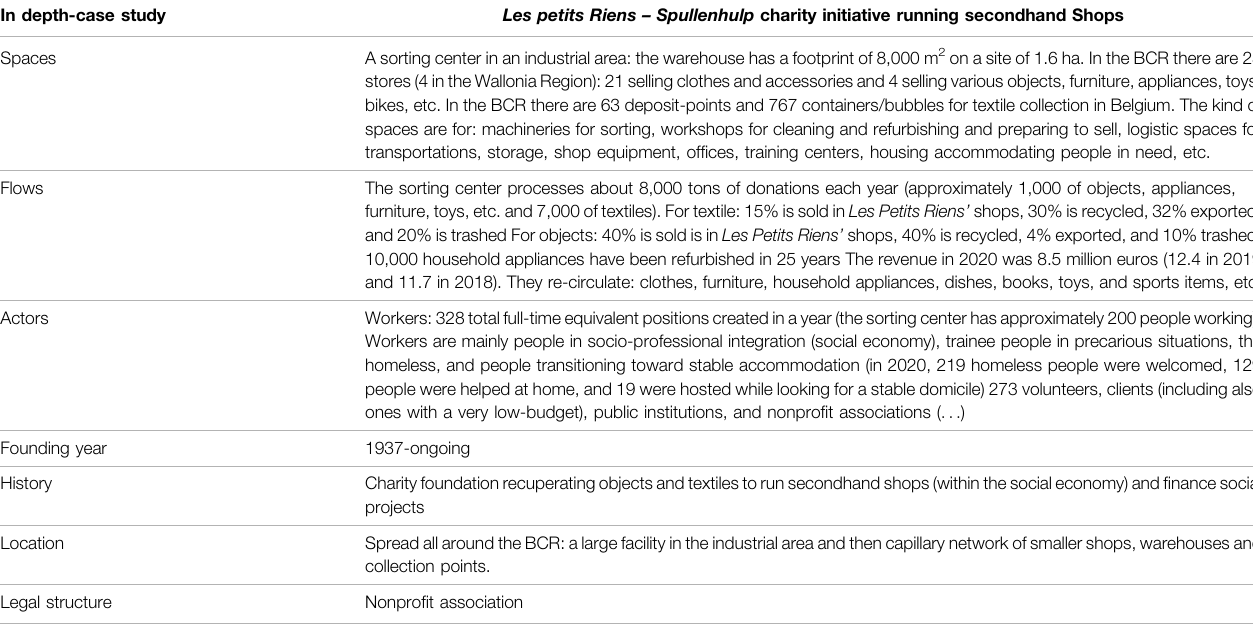
TABLE 5 | Summary of the in-depth case study “ Les Petits Riens-Spullenhulp ”